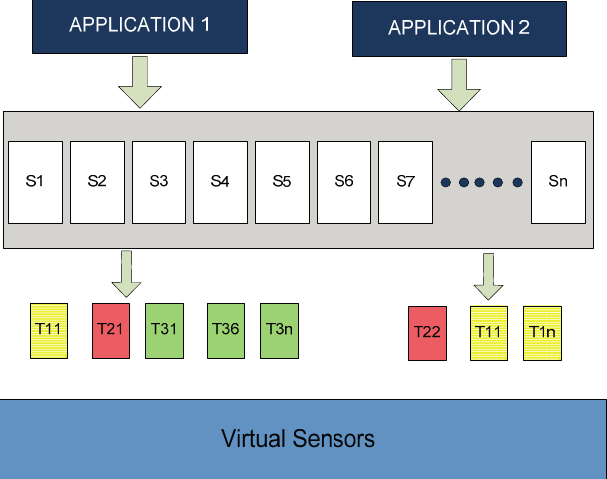
Figure 3. Sensor virtualization: multiple applications using multiple